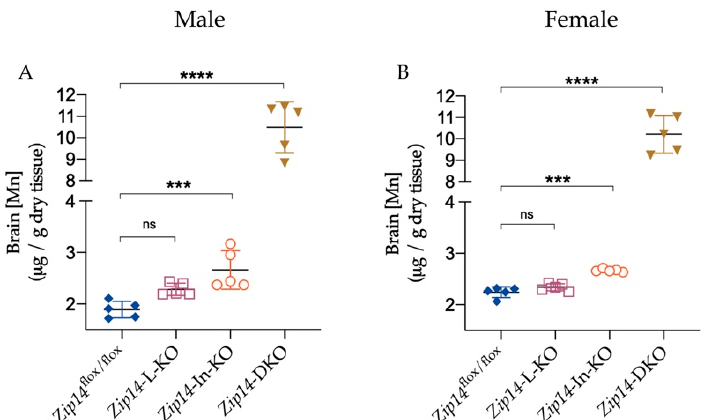
Figure 6. Combined inactivation of intestinal and hepatic ZIP14 greatly exacerbated brain manganese accumulation. Brain Mn concentrations were measured by ICP-MS in ( A ) male ( n = 5) or ( B ) female mice ( n = 5). Data were expressed as mean ± SD and were subjected to a one-way ANOVA followed by the Bonferroni post-hoc test to compare the mean of each knockout group to the control group. *** p < 0.001 and **** p < 0.0001. “ns” indicates no significant differences.